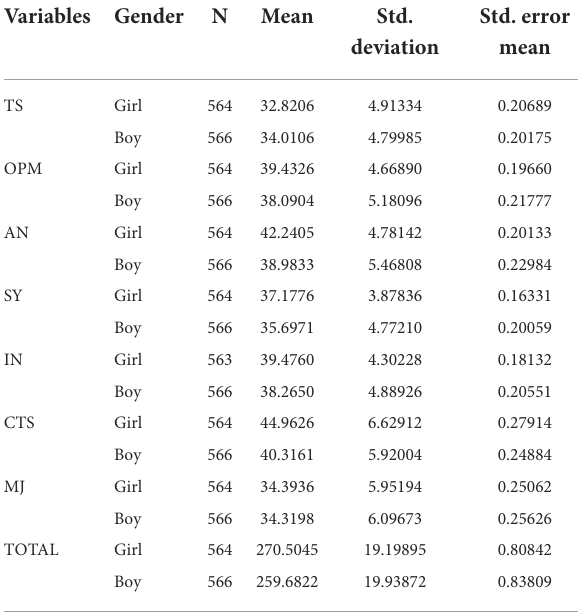
TABLE 3 Descriptive statistics regarding dependent variables across gender.